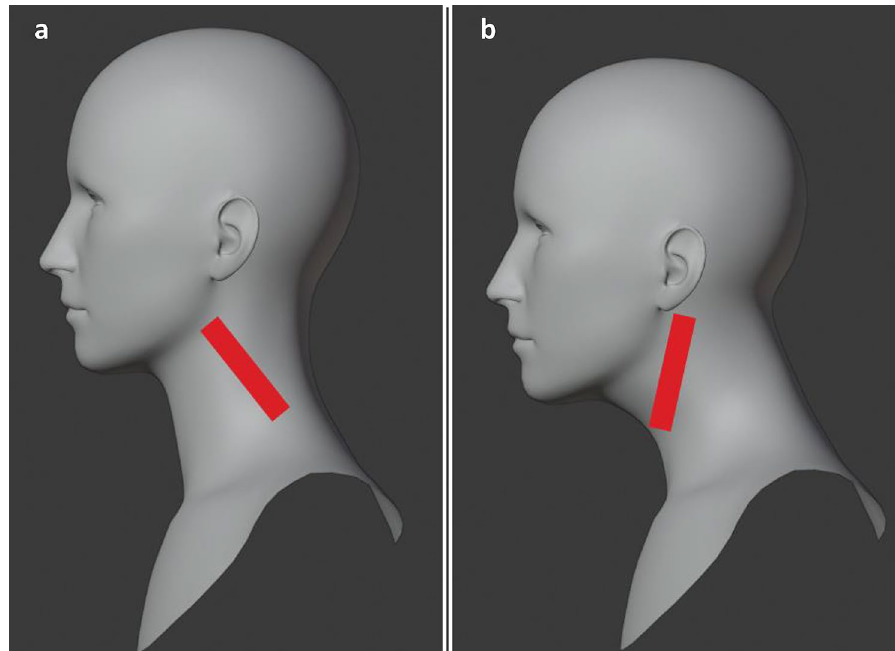
Fig. 3. The neck angle used a line from the midpoint of the mastoid processes to the C7 joint and then forward. The torso angle used a line from C7 joint to the joint of L5 and the first sacral vertebra (S1) and then forward. In all cases, a larger angle indicates greater extension. We defined neck flexion by subtracting the neck angle from the torso angle (Fig. 3a), giving a value that indicates neck flexion rela- tive to the torso, where a more positive angle indicates a more forward head position relative to the torso. Due to anatomical variation, there is no universal neutral angle for the neck.